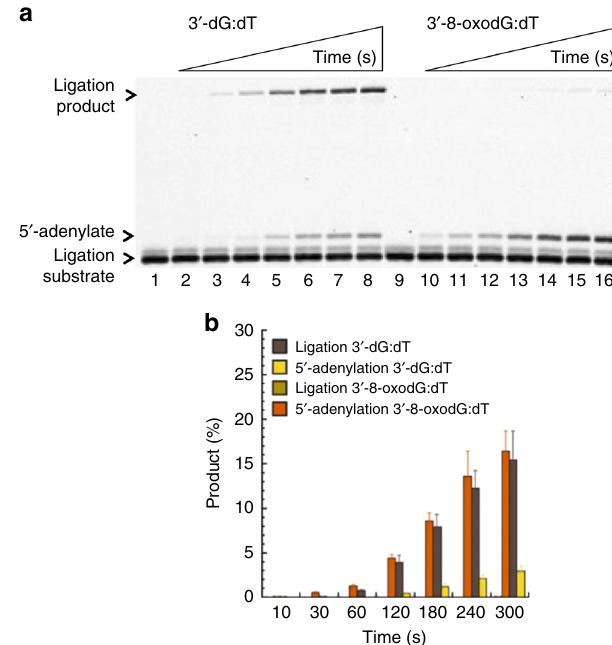
Fig. 2 Ligation of 3 ′ -preinserted dG and 8-oxodG. a Lanes 1 and 9 are the minus enzyme controls for the nicked DNA substrate with 3 ′ -dG and 3 ′ -8- oxodG, respectively. Lanes 2 – 8 and 10 – 16 are the reaction products, and correspond to time points of 10, 30, 60, 120, 180, 240, and 300 s. b Graph shows time-dependent changes in the products of ligation (light and dark brown for ligation of 3 ′ -8-oxodG and 3 ′ -dG, respectively) and 5 ′ - adenylation (orange and yellow for 5 ′ -adenylation following ligation of 3 ′ -8- oxodG and 3 ′ -dG, respectively). The data represent the average of four independent experiments ±SD. Corresponding uncropped gel image is shown Supplementary Fig.